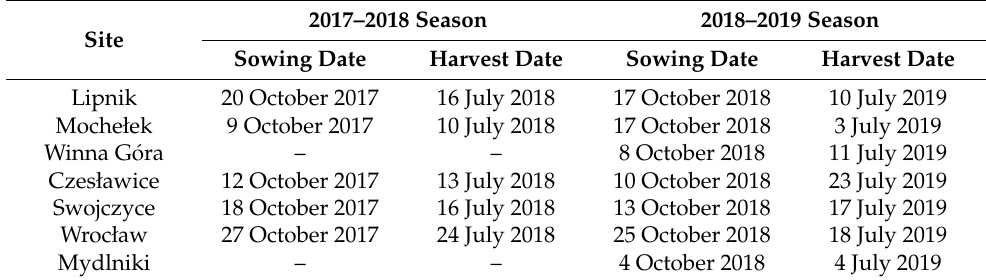
Table 3. Dates of winter wheat sowing and